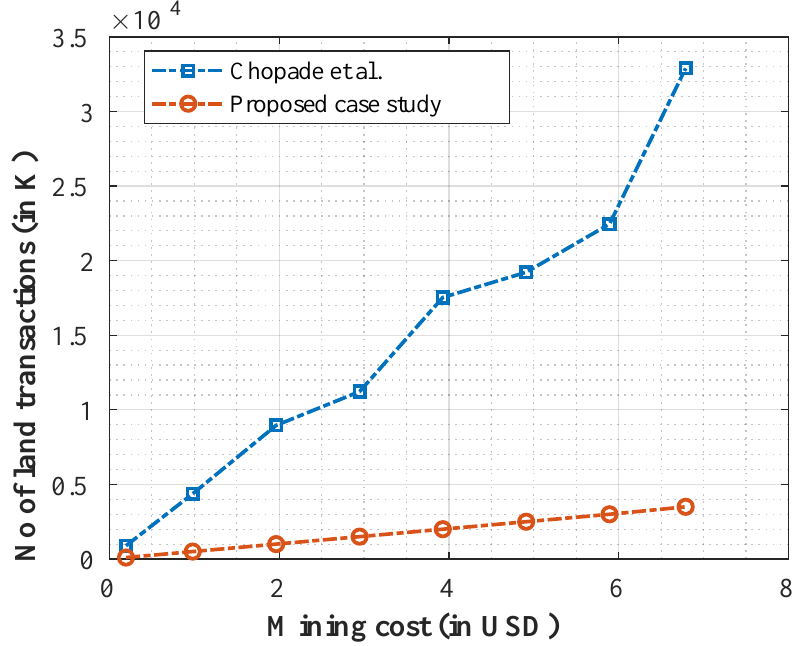
Figure 11. Analysis of mining cost